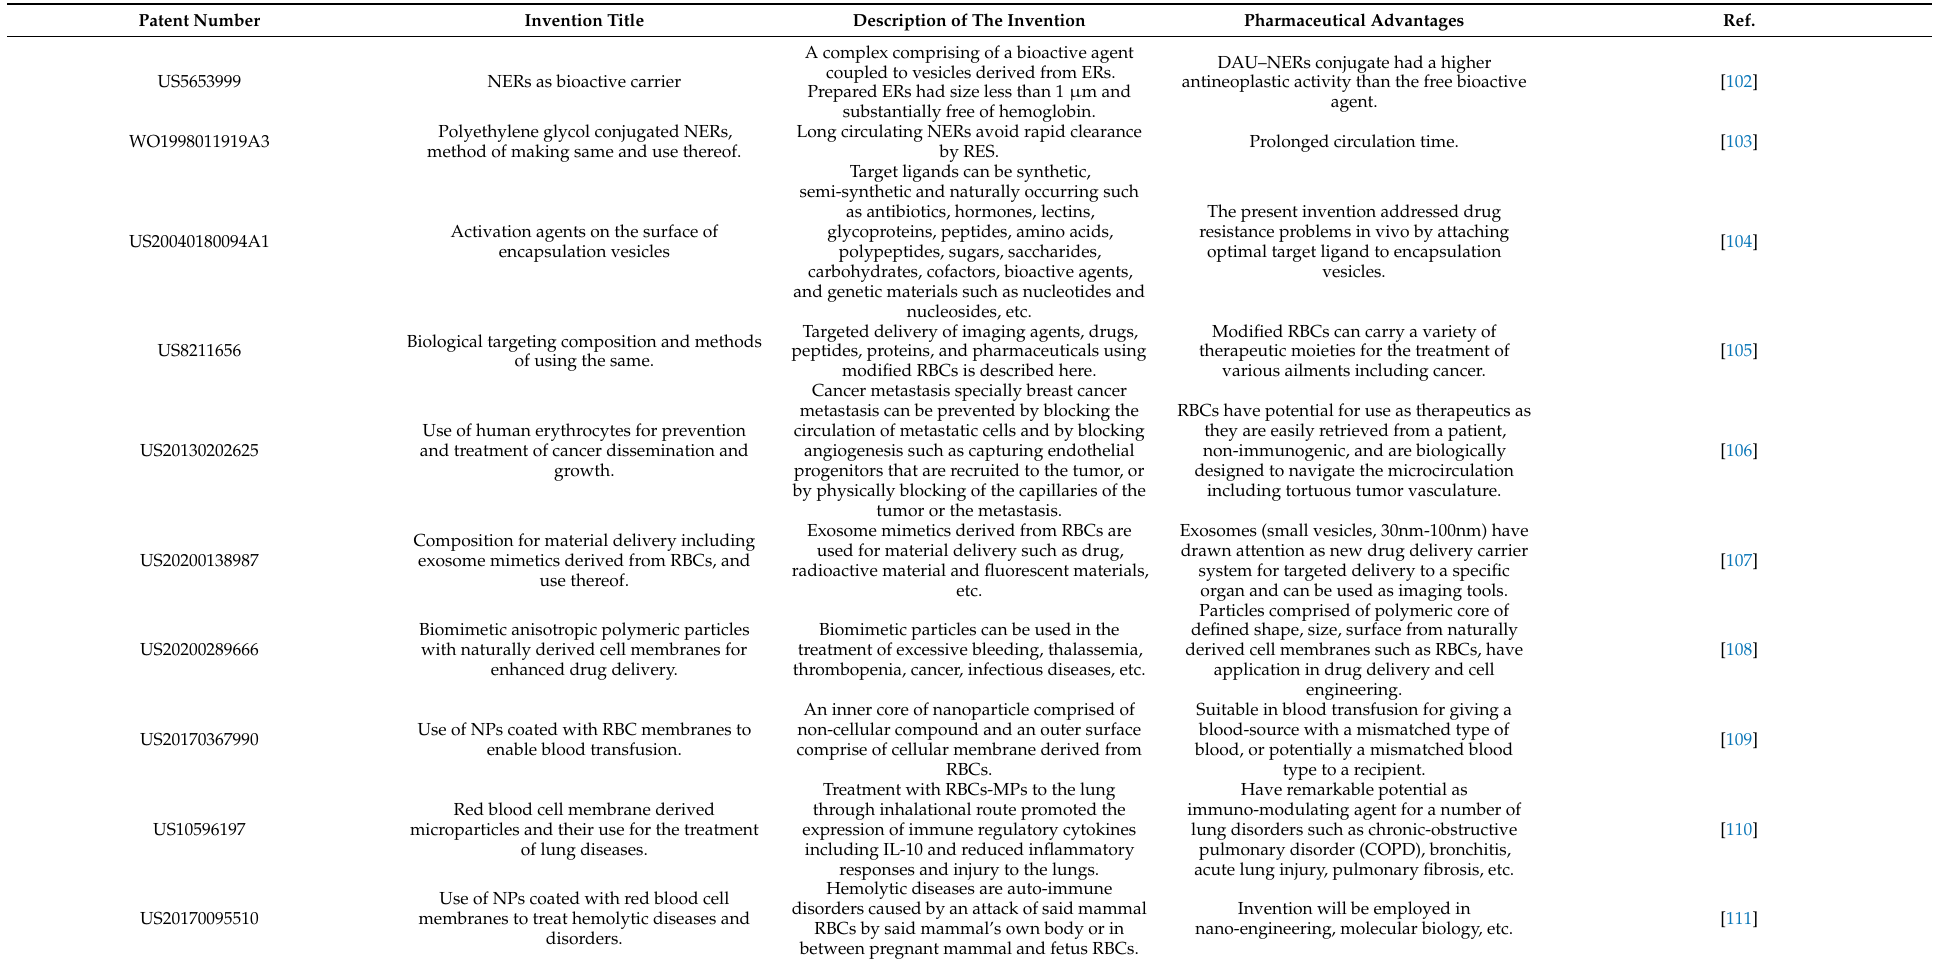
Table 2. Recent patents available on NERs as carrier system for cancer